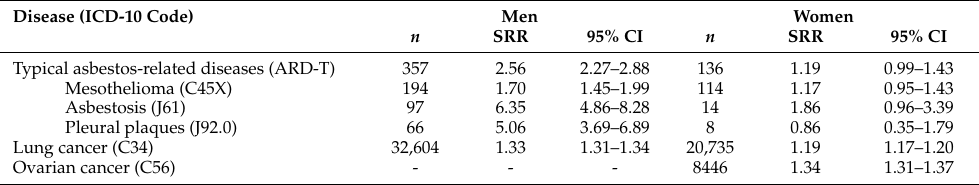
Table 2. Number of deaths ( n ), from pooled and individual ARD-T, and lung and ovarian cancer in the H-ASB municipalities and the standardized rate ratios (SRR) and 95% confidence intervals